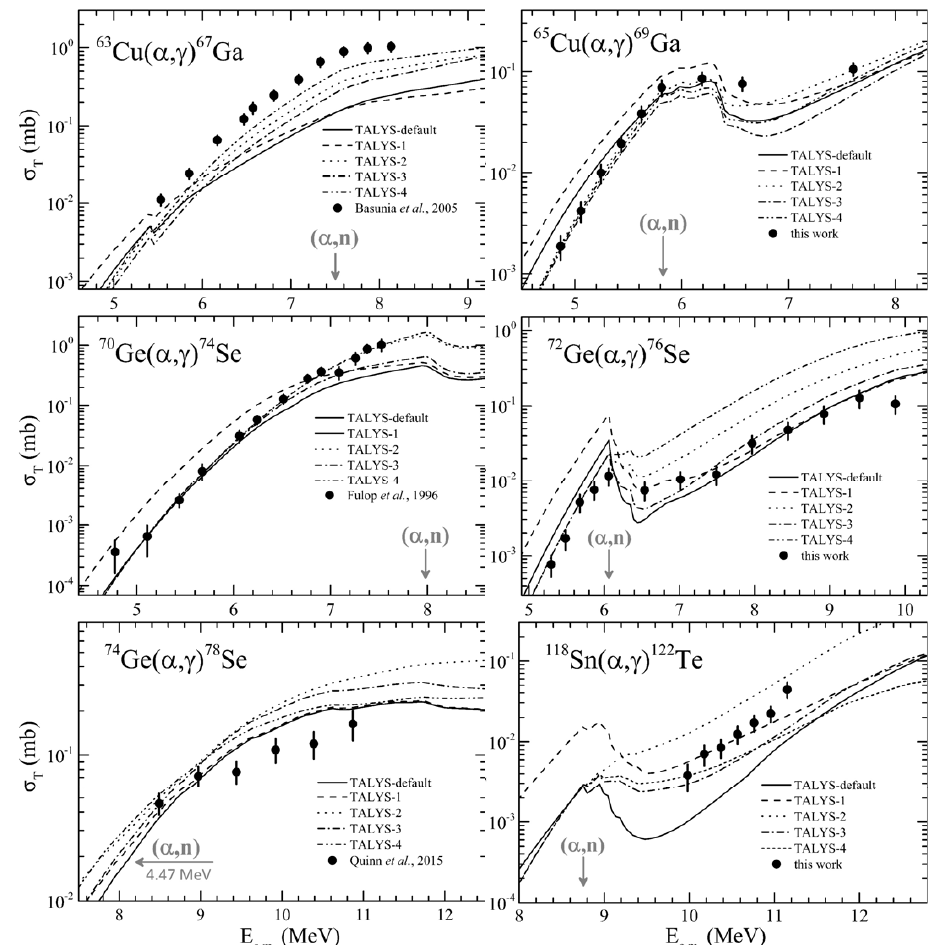
Figure 2. Comparison of experimental ( α, γ ) cross sections (black solid circles) with TALYS calcula- tions. Details are given in section